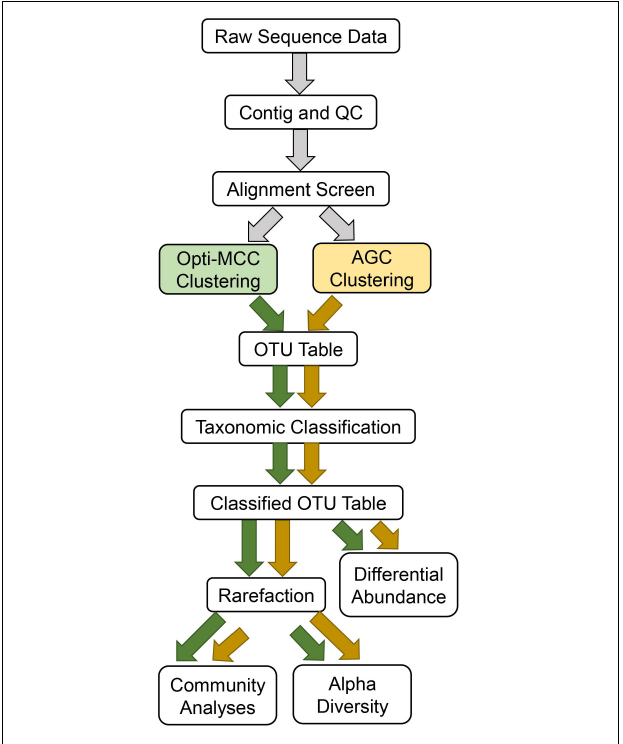
FIGURE 1 | Workflow used for each